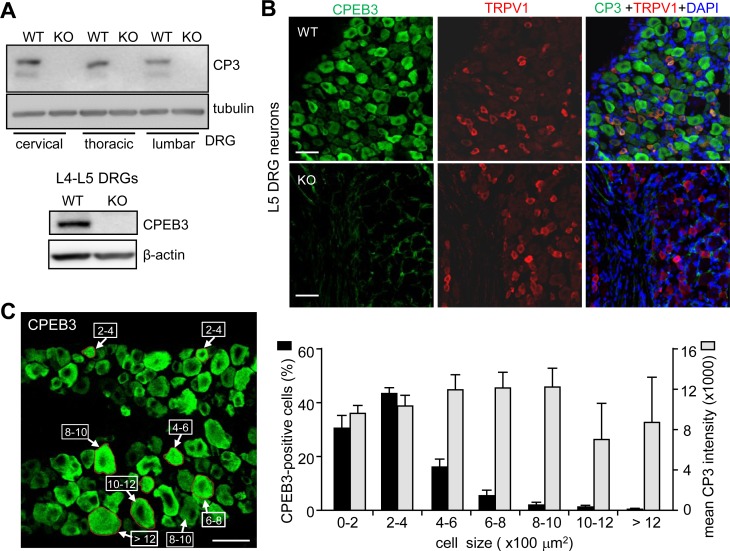
CPEB3 distribution in DRG neurons.(A) CPEB3 (CP3) was detected in cervical, thoracic and lumbar DRG. Lumbar L4-L5 DRGs were isolated and used for western blot or (B) immunostaining assays, both showing CPEB3 immunoreactivity absent in the knockout (KO) DRG neurons. (C) The size of CPEB3-expressing DRG neurons. CPEB3-immunoreactive neurons in several cross-sections of DRG were analyzed for surface area and fluorescence intensity. The percentage of CPEB3-positive cells (black bars) and the mean fluorescence intensity of CPEB3 (grey bars) in DRG neurons of various sizes were expressed as mean ± SEM for L5 DRG isolated from 3 animals. Scale: 50 μm.